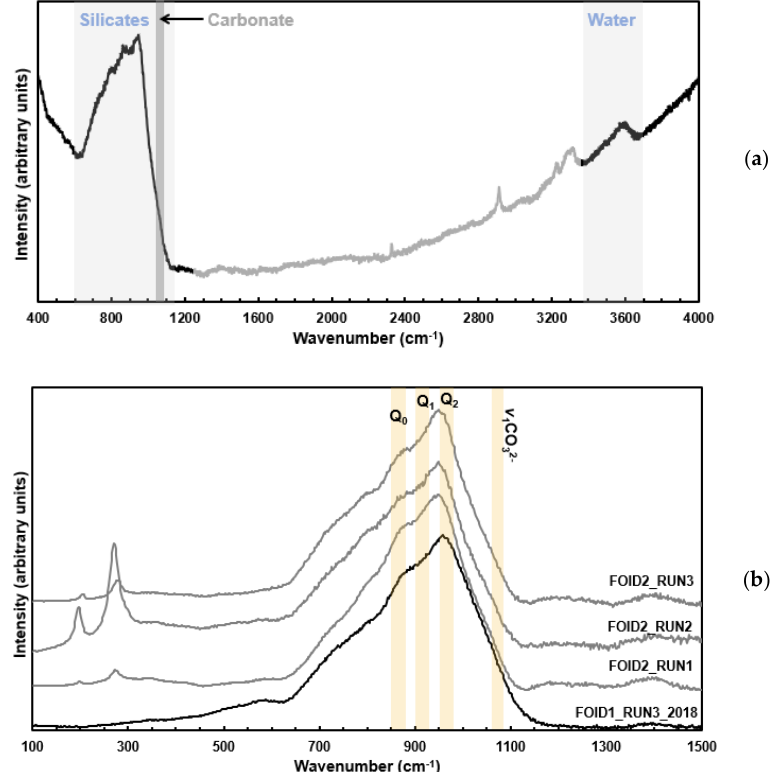
Figure 5. ( a ) Raw Raman spectrum of FOID2_RUN2 showing the silicate, CO 32 − and O – H frequency intervals. ( b ) Background subtracted Raman spectra of the recovered glasses in the Q n and C – O frequency range.